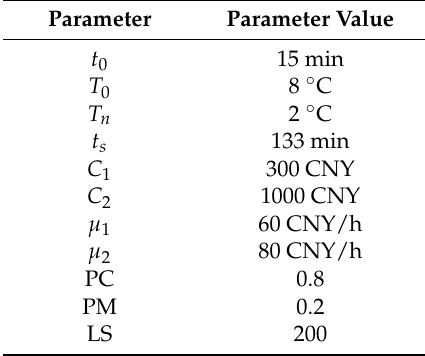
Table 4. Model parameter settings.